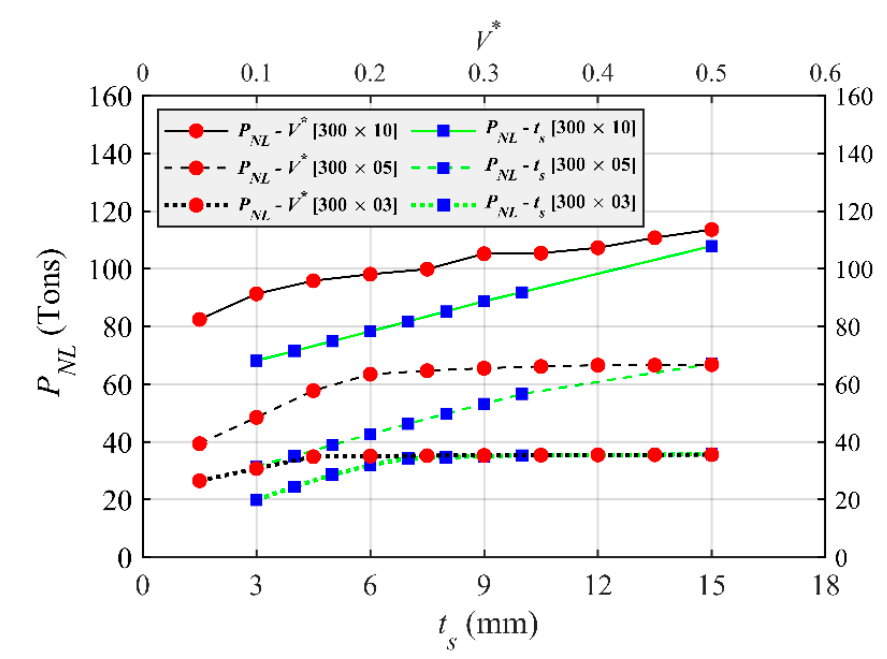
Figure 12. Maximum crane load capacities of SHS columns with uniform and optimal-topology stiffeners.